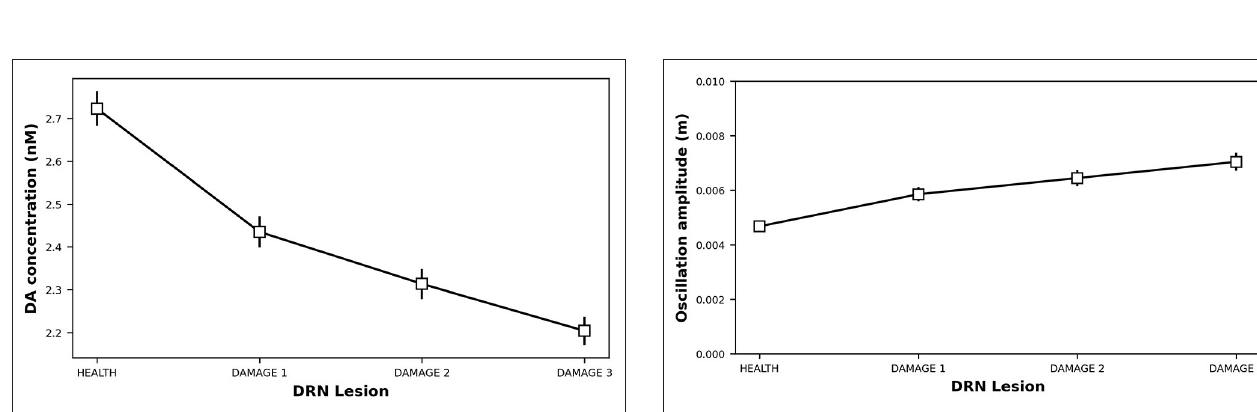
FIGURE 3 | Relationship between activities of model components and changes in DA and 5-HT concentrations. The dotted vertical line represents the timing of the lesion in the dopaminergic circuits ( τ SNc + 25 % , α IP + 11 % ). The four graphs represent: (A) the concentration levels of 5-HT (brown line) and DA (pink line); (B) the spike frequency of DRN (light red line) and SNc (light blue line); (C) the spike frequency of Thal (orange line) and M1 (purple line); (D) the spike frequency of IP (light green line) and DP (dark green line).